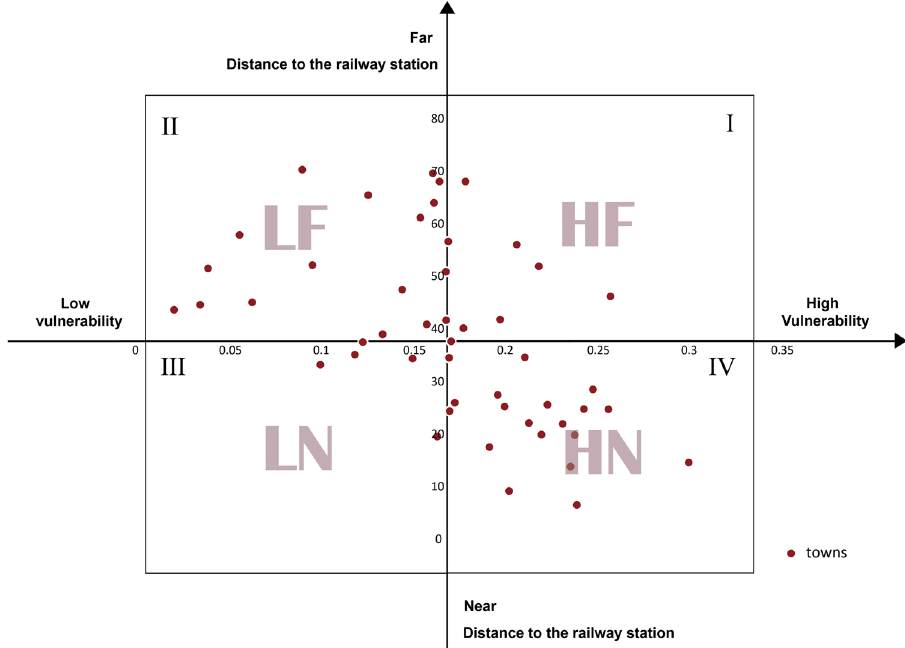
Fig. 5 A four-quadrant diagram of the correlation between the vulnerability of different regions (in terms of the risk of returning to poverty) and the distance to the nearest railway station. LF represents a lower risk of returning to poverty while being far from a railway station; HF represents a higher risk of returning to poverty despite being far from a railway station; LN represents a lower risk of returning to poverty despite being near a railway station; and HN represents a higher risk of returning to poverty while being near a railway station. The Pearson correlation test for vulnerability and the distance to the nearest railway station are presented in Supplementary Table